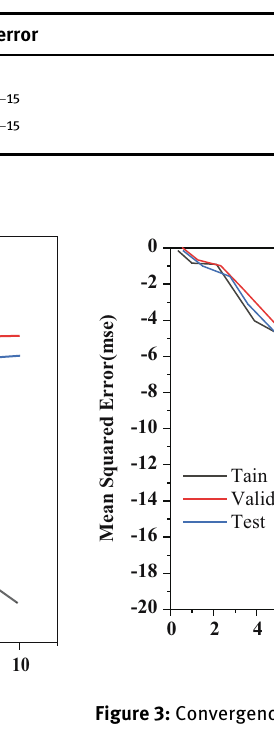
Figure 2: Convergence curve of the classical BP algorithm.